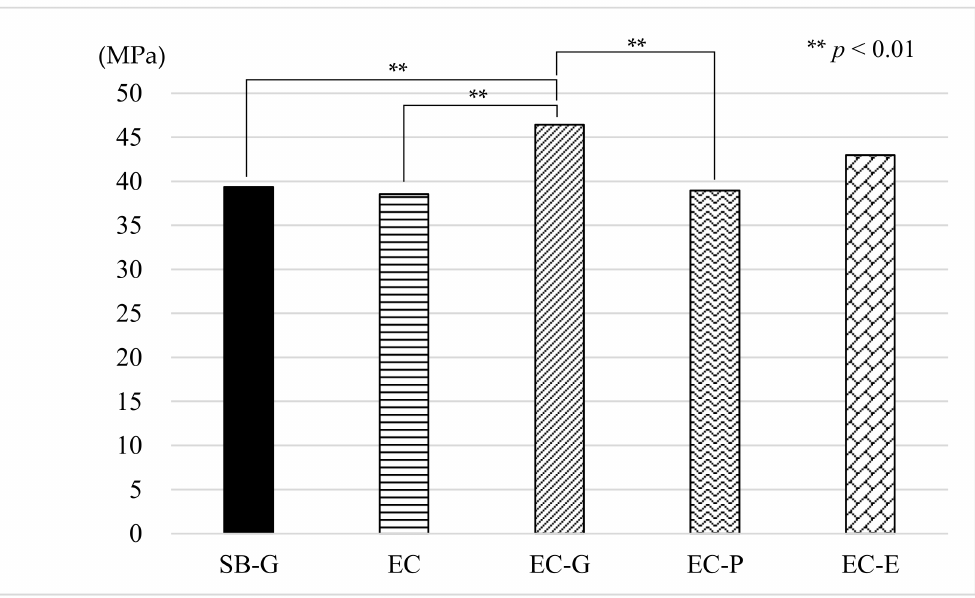
Figure 3. Results of the µ TBS measurements. µ TBS: microtensile bond strength, SB: Super-Bond ® , EC: ESTECORE, G: 10-3 solution, P: phosphate solution, E: ethylenediaminetetraacetic acid, MPa: